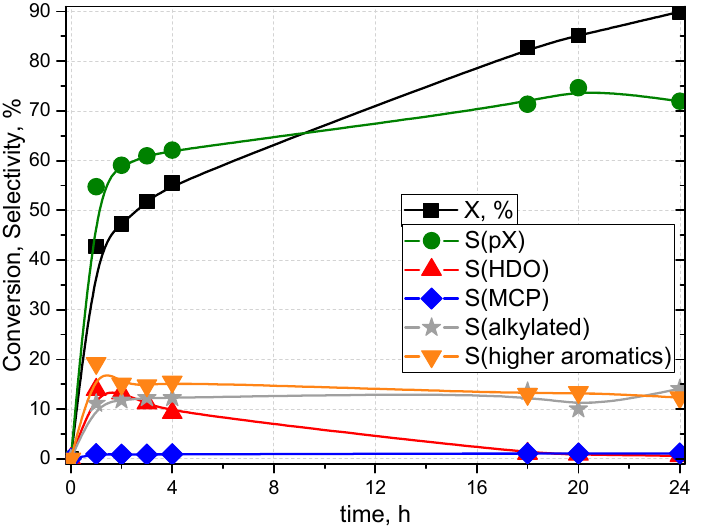
Figure 7. Conversion and selectivities to known products as a function of time for the Diels–Alder cycloaddition of 2,5-dimethylfuran (DMF) and ethylene over H-ZSM-5 (30). Reaction conditions: temperature, 250 °C; pressure, 55 bar; catalyst, 120 mg; 30 mL of 3 M DMF in n -octane; and stirring, 1100 rpm. Mass balance increased from 66% at first sampling to 73% at the end of the reaction.